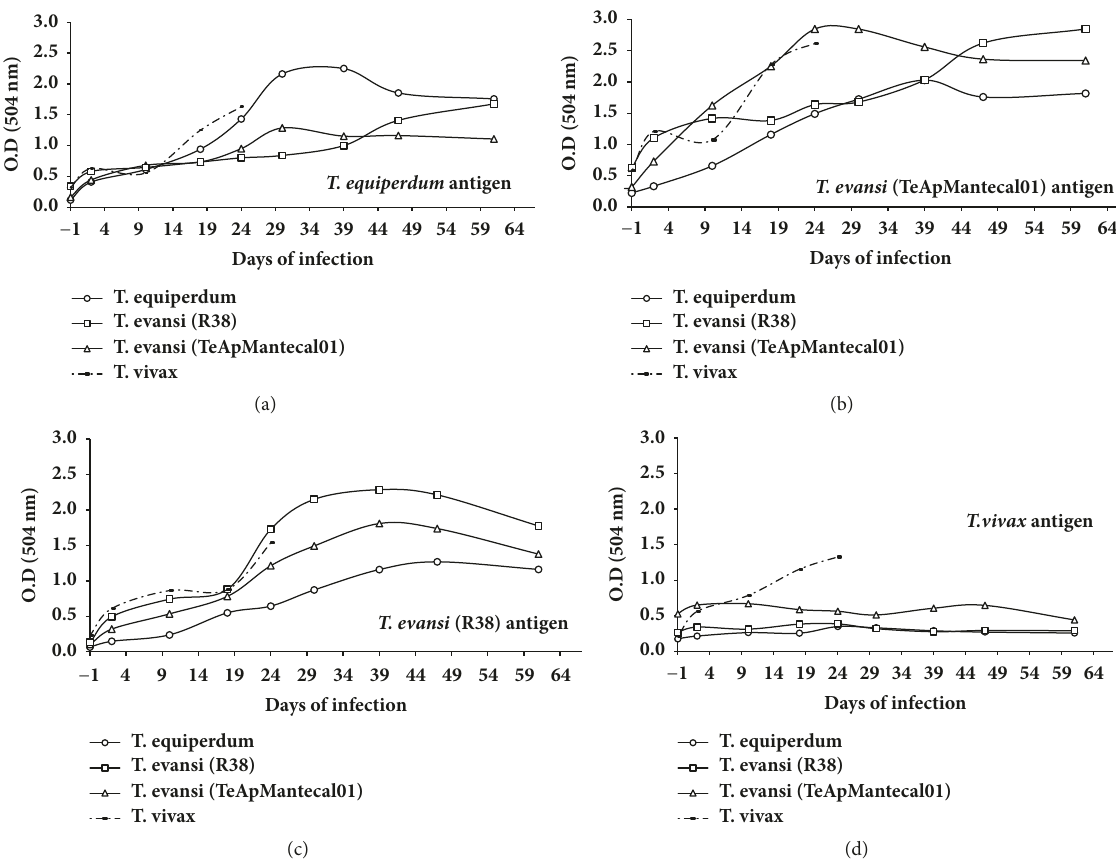
Figure 3: Antibody response in serum in experimental sheep infection by Trypanosoma evansi (TeApMantecal01 and R38), Trypanosoma equiperdum (TeAp-N/D1), and Trypanosoma vivax (Tucacas) isolates. (a) Sera from all sheep against T. equiperdum (TeAp-N/D1) antigen. (b) Sera from all sheep against T. evansi (TeApMantecal01) antigen. (c) Sera from all sheep against T. evansi (R38) antigen. (d) Sera from all sheep against T. vivax (Tucacas)